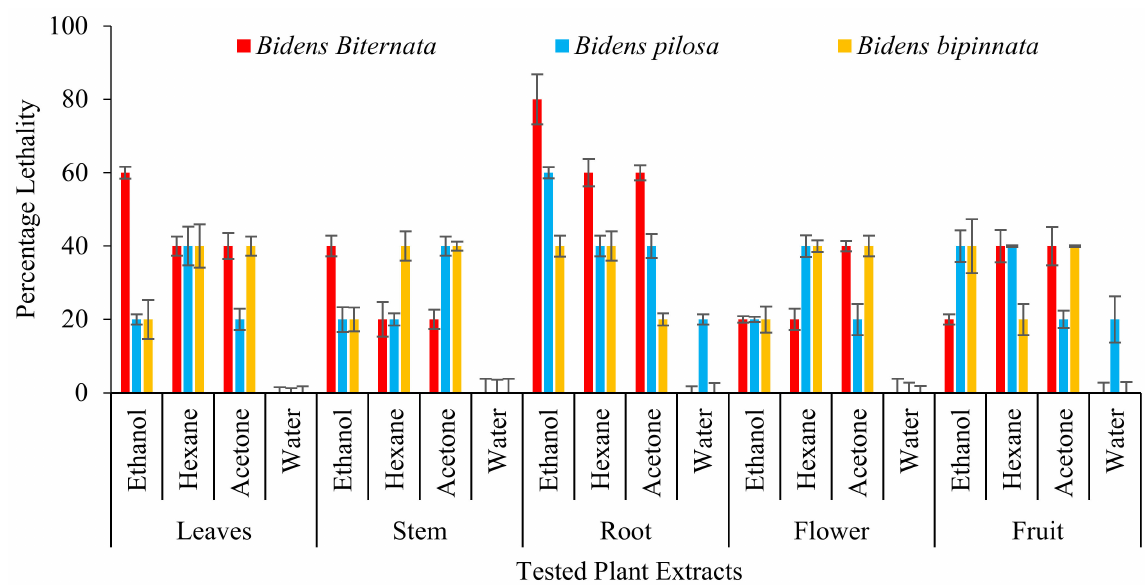
Figure 4. Percentage death of Zebra fishes after treatment of plant extracts.